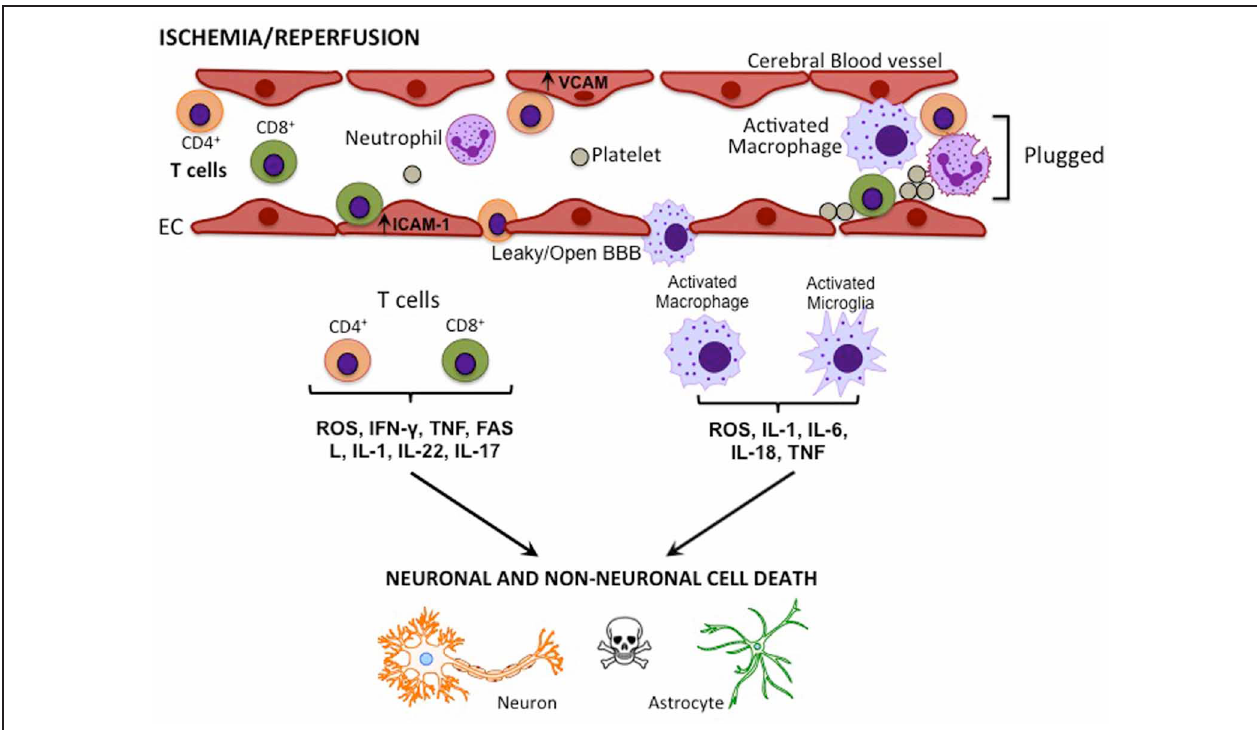
FIGURE 1 | Cytokines/effector molecules involved in post-stroke inflammation in the brain. Following cerebral ischemia-reperfusion, elevated levelsofadhesion molecules,suchasICAM-1andVCAMinvascularendothelial